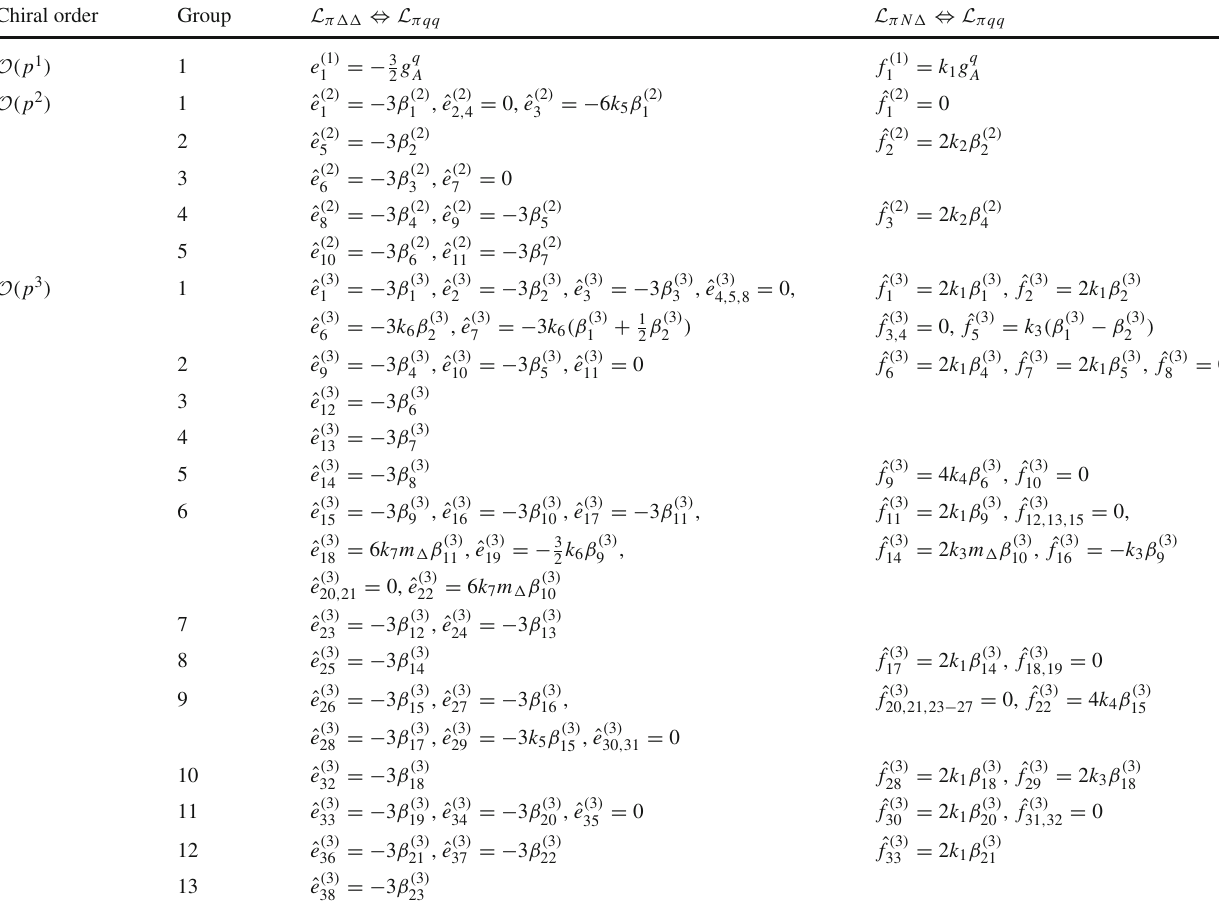
Table 4 Obtained coupling constant relations between L π(cid:2)(cid:2),π N (cid:2) and L π qq Chiral order